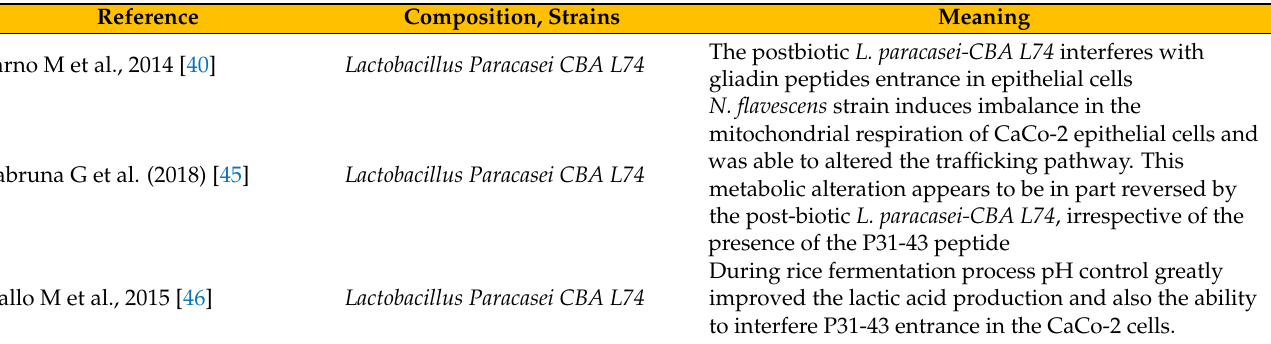
Table 4. In vitro study using LP CBA L74 post-biotc.